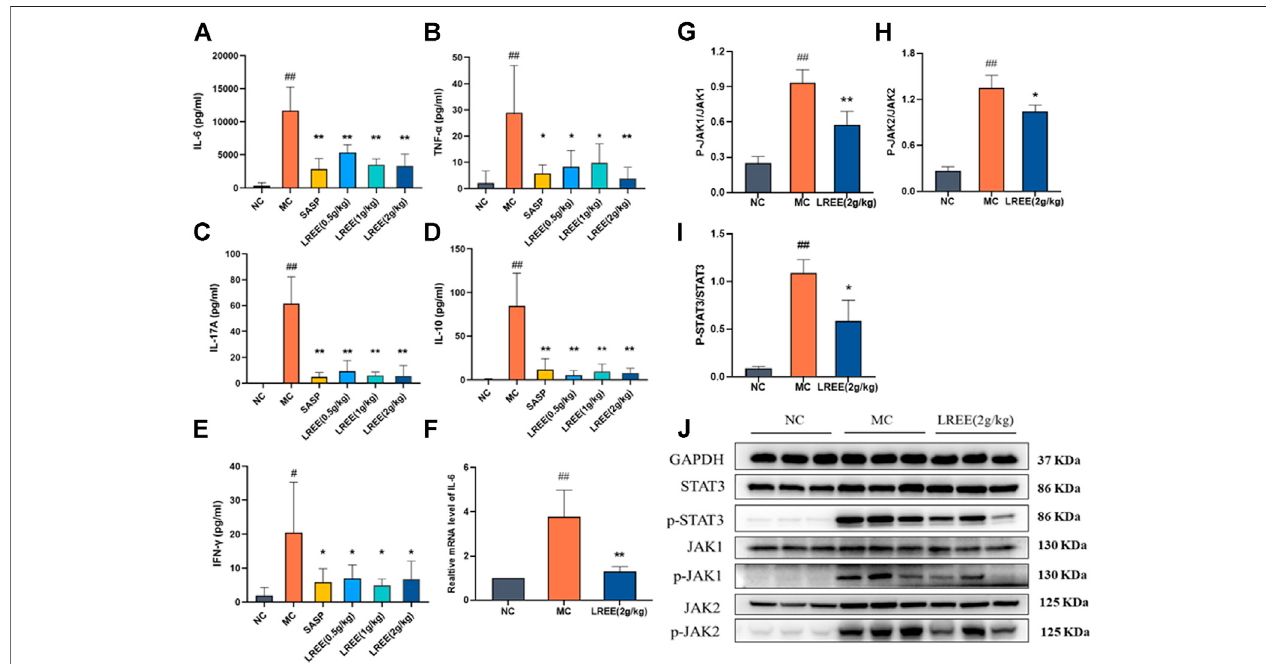
FIGURE 3 | LREE could ameliorate intestinal in fl ammation and inhibit the phosphorylation of IL-6/STAT3 pathway-associated proteins in ulcerative colitis model mice ( n (cid:2) 6). (A – E) The protein levels of in fl ammatory cytokines in the colon of mice. (F) The mRNA level of IL-6 in the colon of mice. (G – I) Densitometry analysis of phosphorylated JAK1, JAK2, and STAT3 levels. (J) WB analysis of STAT3, phospho-STAT3, JAK1, phospho-JAK1, JAK2, and phospho-JAK2 in the colon of mice. # P ＜ 0.05, ## P ＜ 0.01 vs. NC group. * P ＜ 0.05, ** P ＜ 0.01 vs. MC